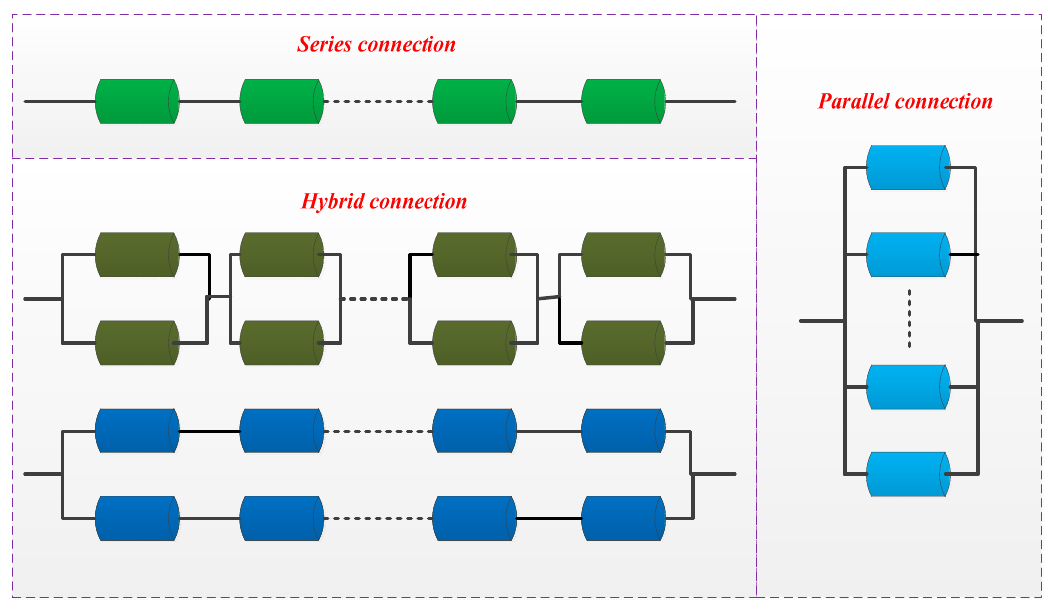
Figure 11. Different battery pack structures.